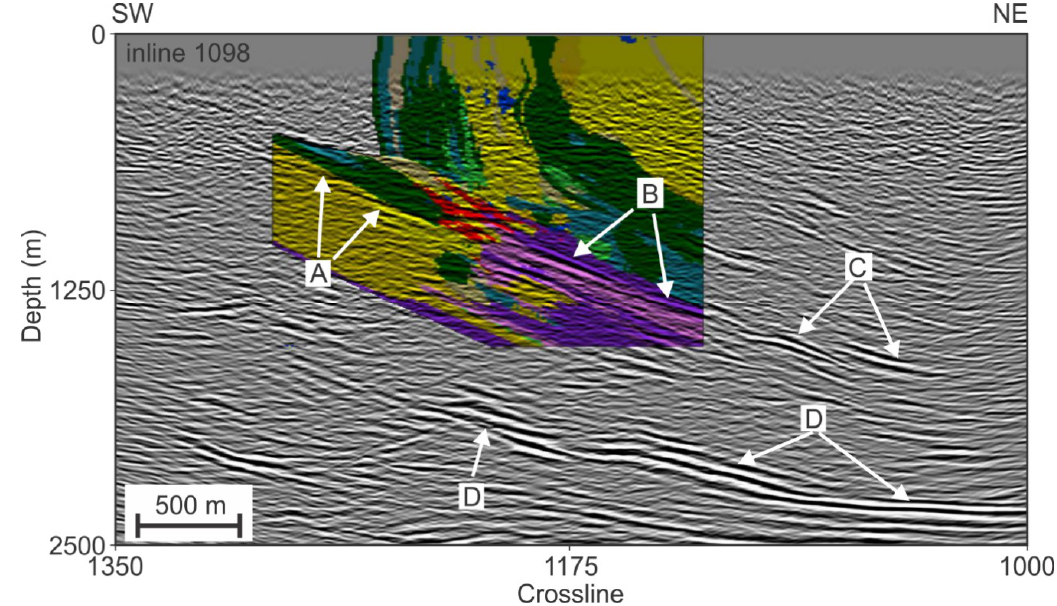
Figure 10. Inline 1089 from the final migrated seismic volume with a coincident section from the 3D geological model overlaid on top of the seismic section. See text for details on events indicated by arrows. Modified from [4].